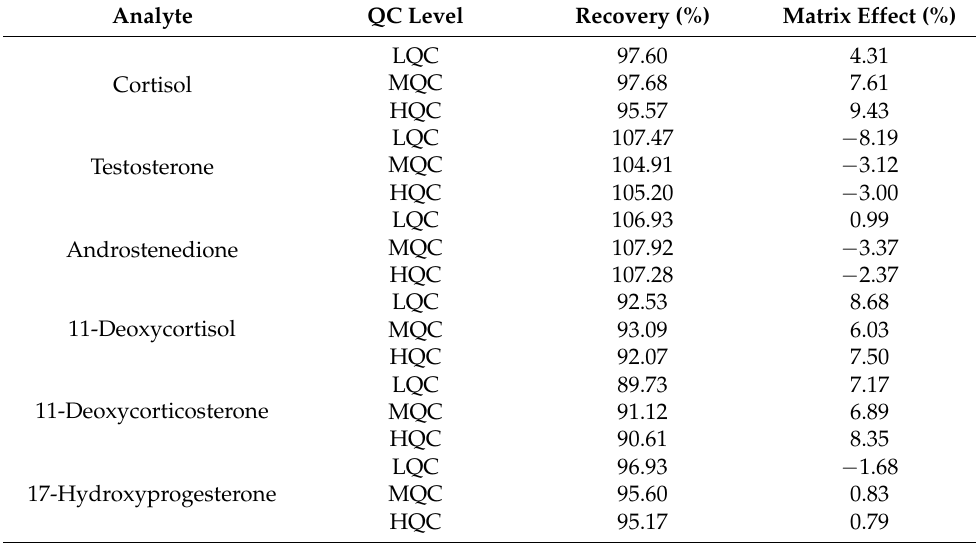
Table 1. Mean extraction recoveries and matrix effect of the steroid hormones in tissue homogenates ( n = 5).